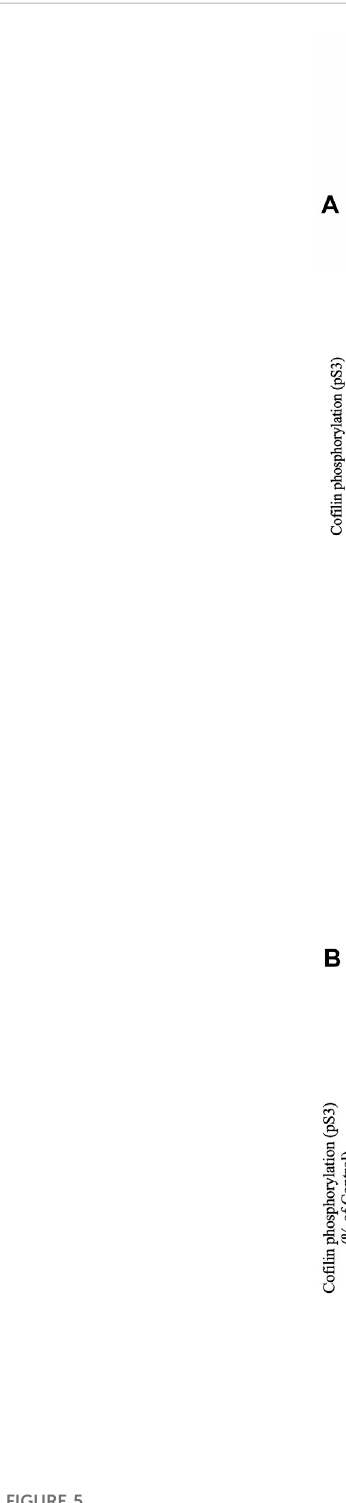
FIGURE 5 Effect of two serine protein phosphatase inhibitors, calyculin A and okadaic acid, and a Calcineurin inhibitor, FK-5046, on the ability of CCK-8 (0.3and100 nM) (A,B) orTPA(1 µM) (B) toaltertheactivationofco fi lin.IsolatedpancreaticaciniwereincubatedintheabsenceorpresenceofcalyculinA (1 nM), okadaic acid (10 nM) or FK-506 (10 µM) for 3 h and then incubated with no addition (control), CCK-8 (0.3 and 100 nM) for 3 min or TPA (1 µM) for 5 min, and then lysed. Western blots were analyzed using anti-pS3 co fi lin. Bands were visualized using chemiluminescence and quanti fi ed by densitometry. Top : Results of a representative blot of four independent experiments are shown. Bottom : Means ± S.E. of at least 4 independent experiments. For (A) , results are expressed as % of basal stimulation of each control group. In Figure 4A, calyculin A and okadaic acid decreased the basal level of co fi lin phosphorylation by 24% and 12%, respectively. For Figure 4B, results are expressed as % of basal stimulation of the control group with no additions. *, p < 0.05 compared to the control group; ∞ , p < 0.05 compared to stimulants without